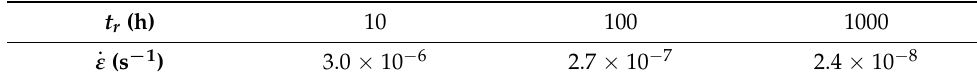
Table 3. Correspondence table of creep life and minimum creep